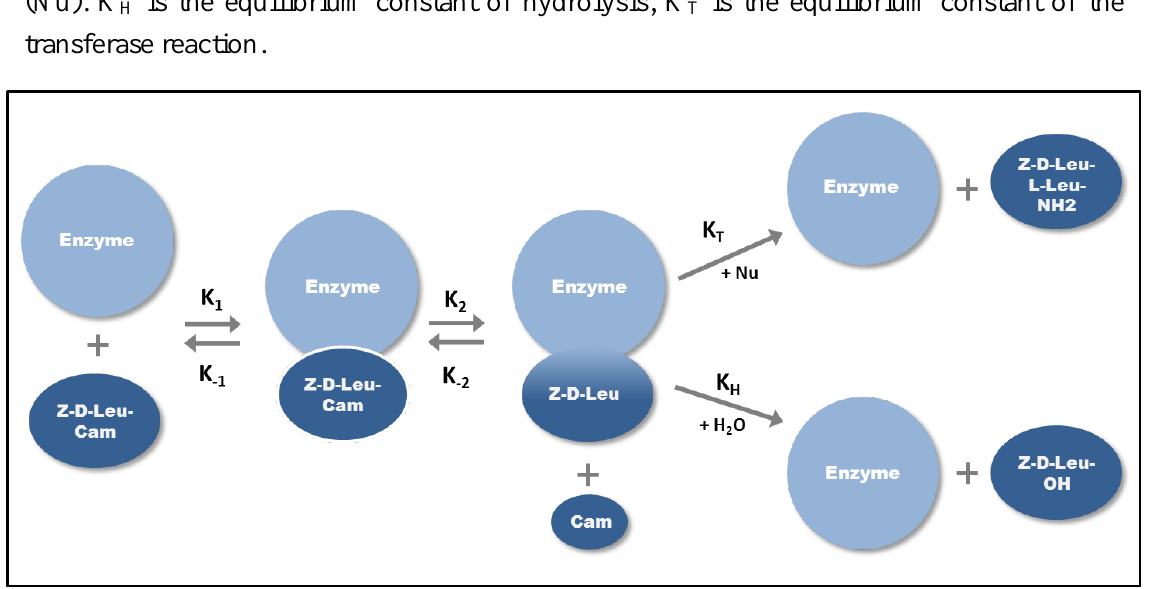
dipeptide. After the 2 ) a covalent enzyme-substrate intermediate is 1 O or other nucleophiles 2 is the equilibrium constant of the T